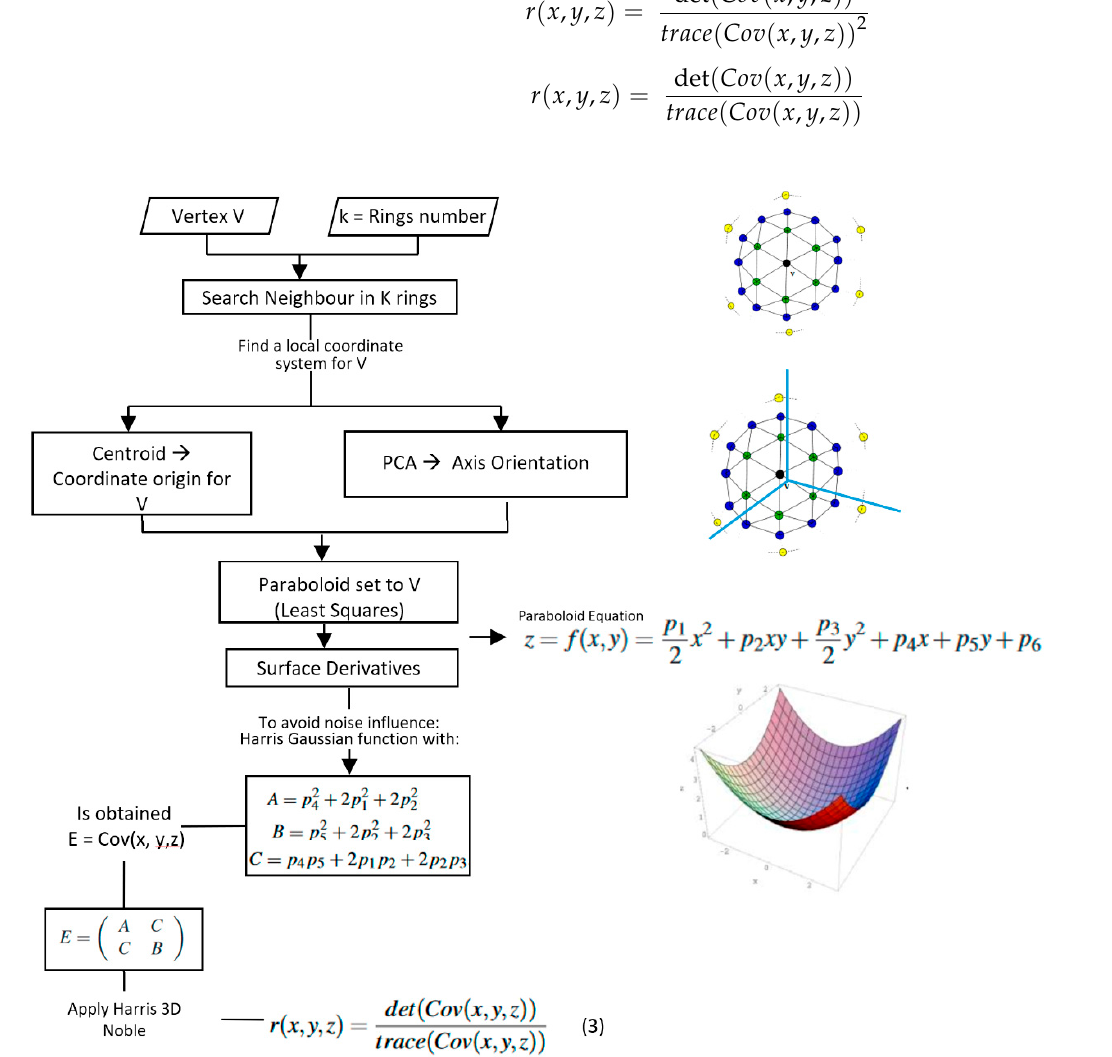
Figure 6. Harris 3D Noble detector: performance mode.